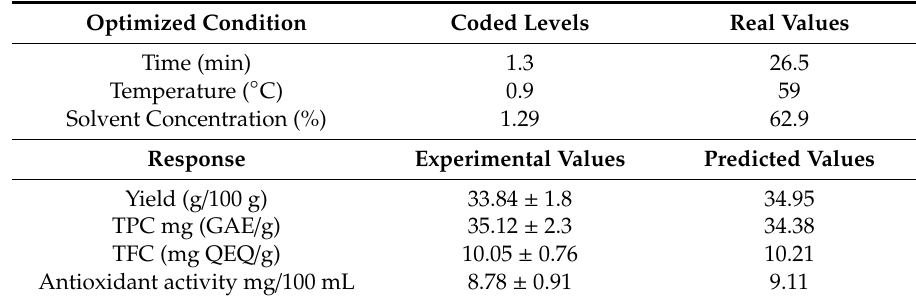
Experimental and predicted values of responses at optimized conditions of independent